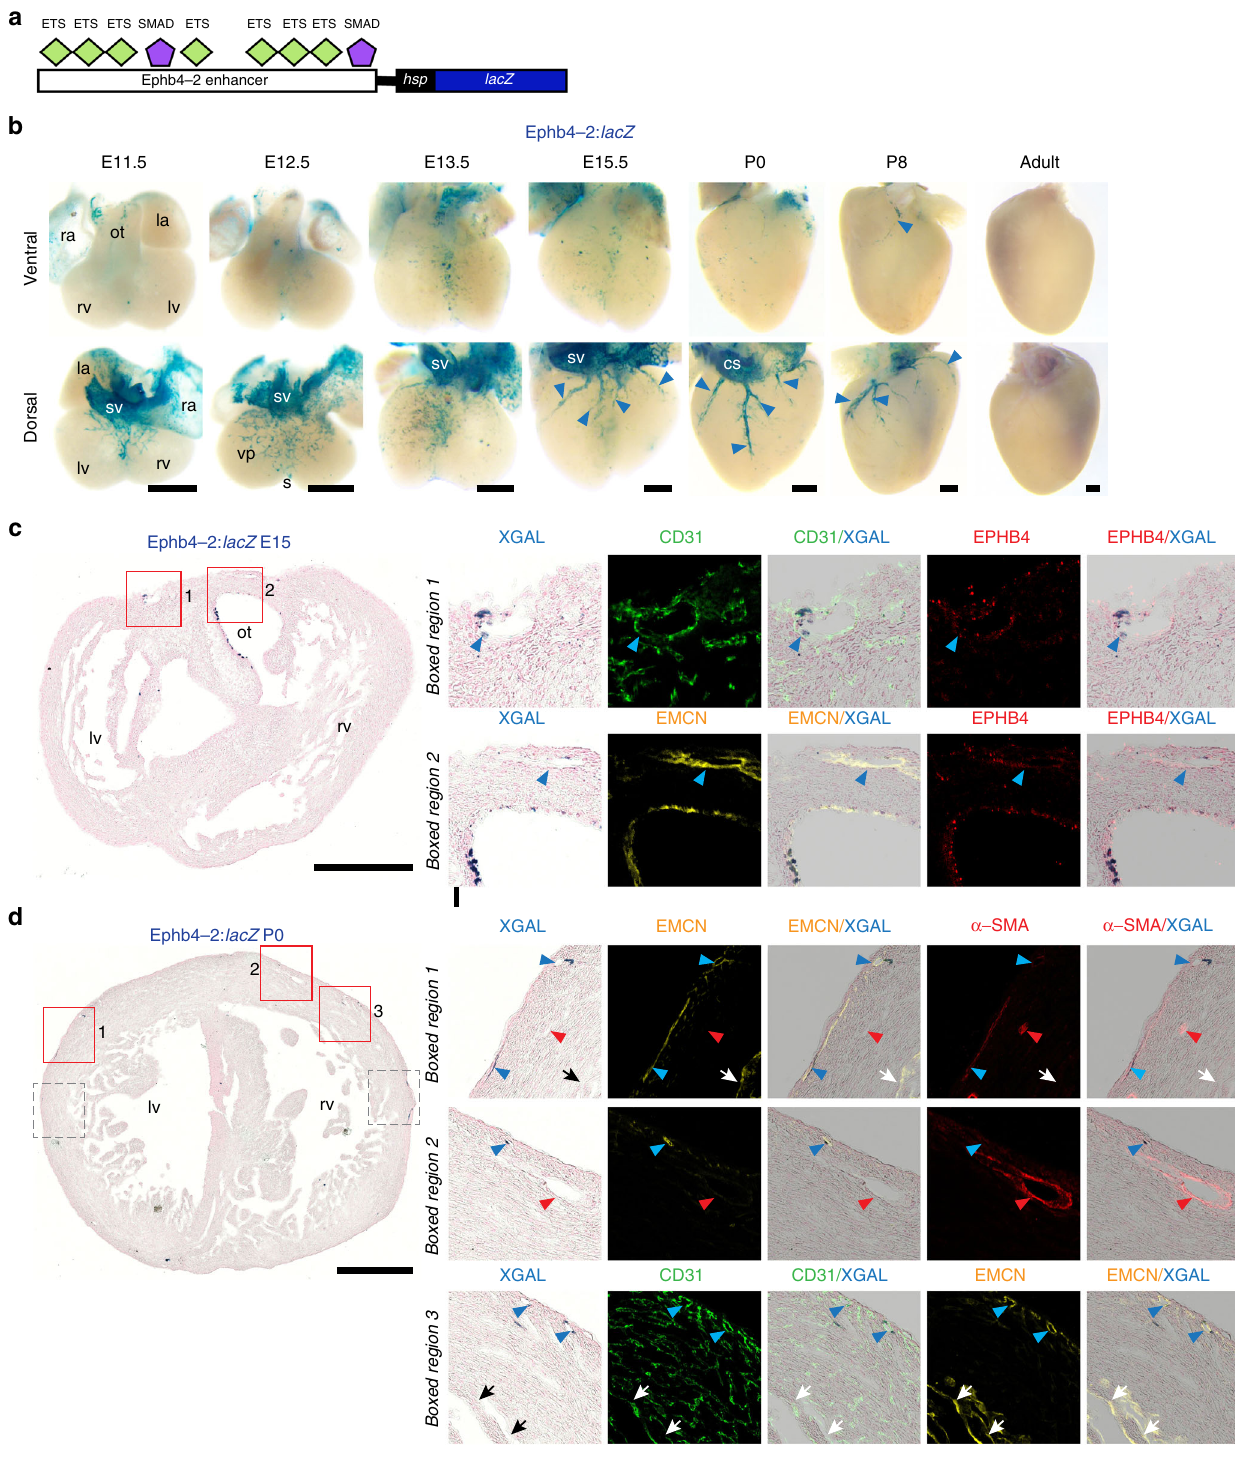
Fig. 7 The vein-speci fi c EphB4-2 enhancer is active in the SV, SV-derived vascular plexus and in mature coronary veins. a Schematic showing the EphB4-2 enhancer: lacZ transgene, with veri fi ed binding motifs for ETS and SMAD1/5 transcription factors represented by coloured shapes 22 . b Whole-mount images of embryonic and post-natal EphB4-2: lacZ transgenic hearts, showing strong enhancer activity in the SV and the early SV-derived plexus on the dorsal aspect. From E15.5, activity is restricted to the coronary veins (blue arrowhead). All images are from a single transgenic line and are representative of at least fi ve biologically independent samples, little variation in staining pattern was seen. c , d Transverse sections through E15.5 ( c ) and P0 ( d ) EphB4-2: lacZ heart. Enhancer activity (blue) is compared to pan-endothelial marker CD31 (green), venous marker EPHB4 (red in top panel), venous/endocardial marker EMCN (yellow) and arterial markers α -SMA (red in middle panel). Representative of six ( c ) and three ( d ) biologically independent immunohistological experiments, with similar staining patterns seen in all. Grey boxed regions shown in Supplementary Fig. 15a. Black/white arrows indicate the endocardium, red arrowheads indicate arteries, blue arrowheads indicate veins. ra, right atrium; la, left atrium; rv, right ventricle; lv, left ventricle; sv, sinus venosus; ot, out fl ow tract; vp, vascular plexus; s, septum; cs, coronary sinus. Black scale bars represent 500 μ m NATURE COMMUNICATIONS| (2019) 10:3276